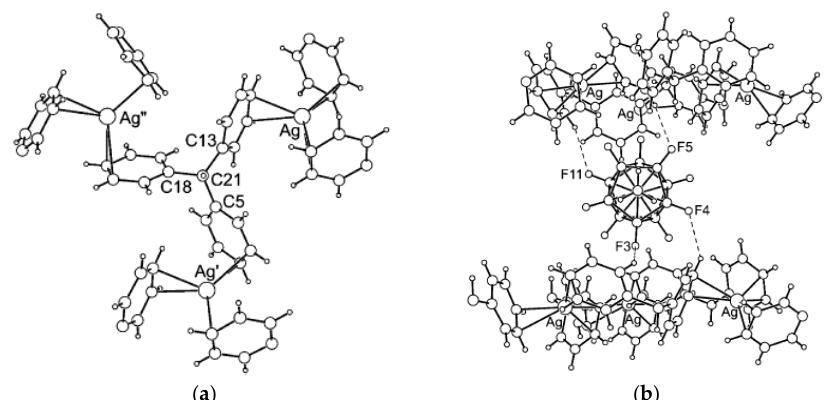
Figure 79. The coordination sphere of the Ag atom ( a ) and crystal packing ( b ) in the structure of {Ag(CHPh 3 )[1-Me-1-CB 11 F 11 ]} n . Reprinted with permission from reference [101]. Copyright © (2004) American Chemical Society.